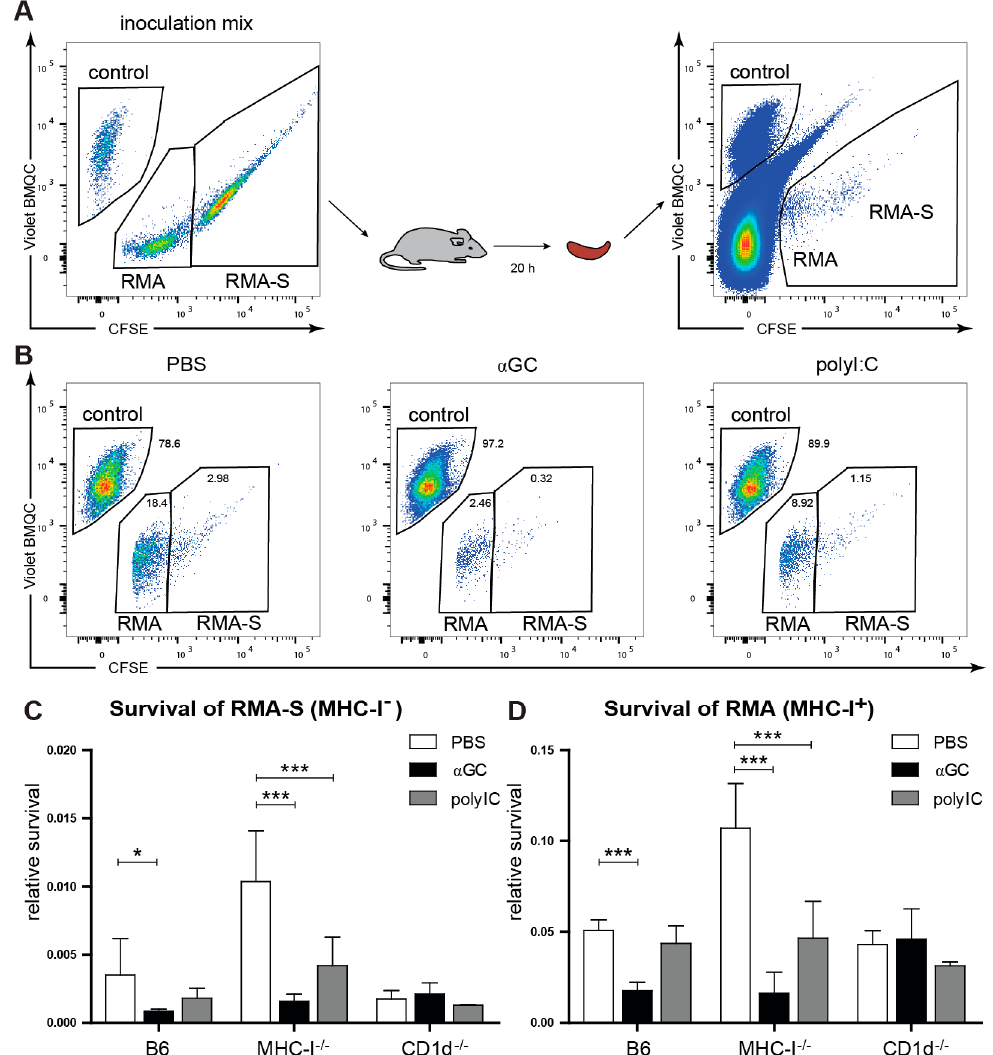
Figure 5. Increased anti-tumor responses after α GC-treatment. C57Bl/6, MHC-I − / − or CD1d − / − mice were injected i.v., with PBS, α GC or polyI:C. 3 days after in vivo stimulation, survival of MHC-I + RMA (labeled with 0.5 uM CFSE) or MHC-I − RMA-S (labeled with 5uM CFSE) tumor target cells was tested in reference to Violet BMQC-labeled MHC-I + splenocytes (control) ( A ). Relative survival of MHC-I + RMA or MHC-I − RMA-S cells ( B – D ) was assessed by comparing the frequency of remaining target cells to an inert control cell population (NK1.1-depleted B6 spleen cells), as explained in Materials and Methods. ( B ) shows representative flow cytometry plots for B6 mice treated with PBS, α GC or poly-I:C. ( C ) The relative survival of remaining MHC-I − target cells and ( D ) the relative survival of MHC-I + target ( D ) are shown. ( C , D ) A total of 6–8 mice per group were tested (compiled from 2 independent experiments). Error bars denote SD. Significant differences were calculated within each mouse strain by one-way ANOVA with Dunnett’s correction for multiple testing and are denoted * p < 0.05, *** p <